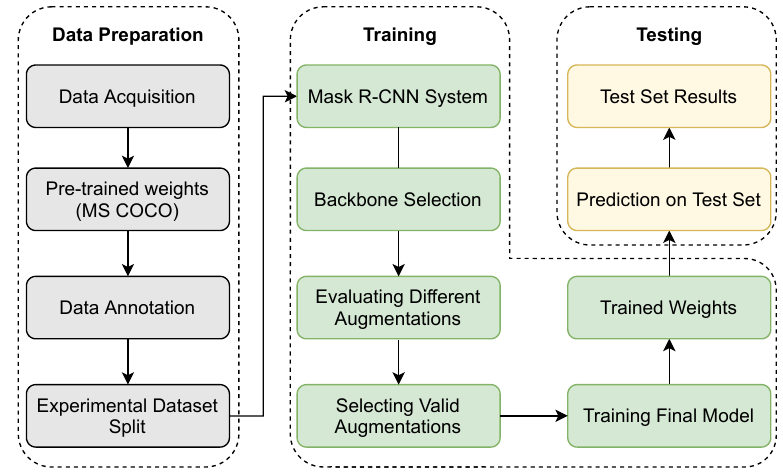
Figure 1. Flowchart for developing a system to detect strawberry